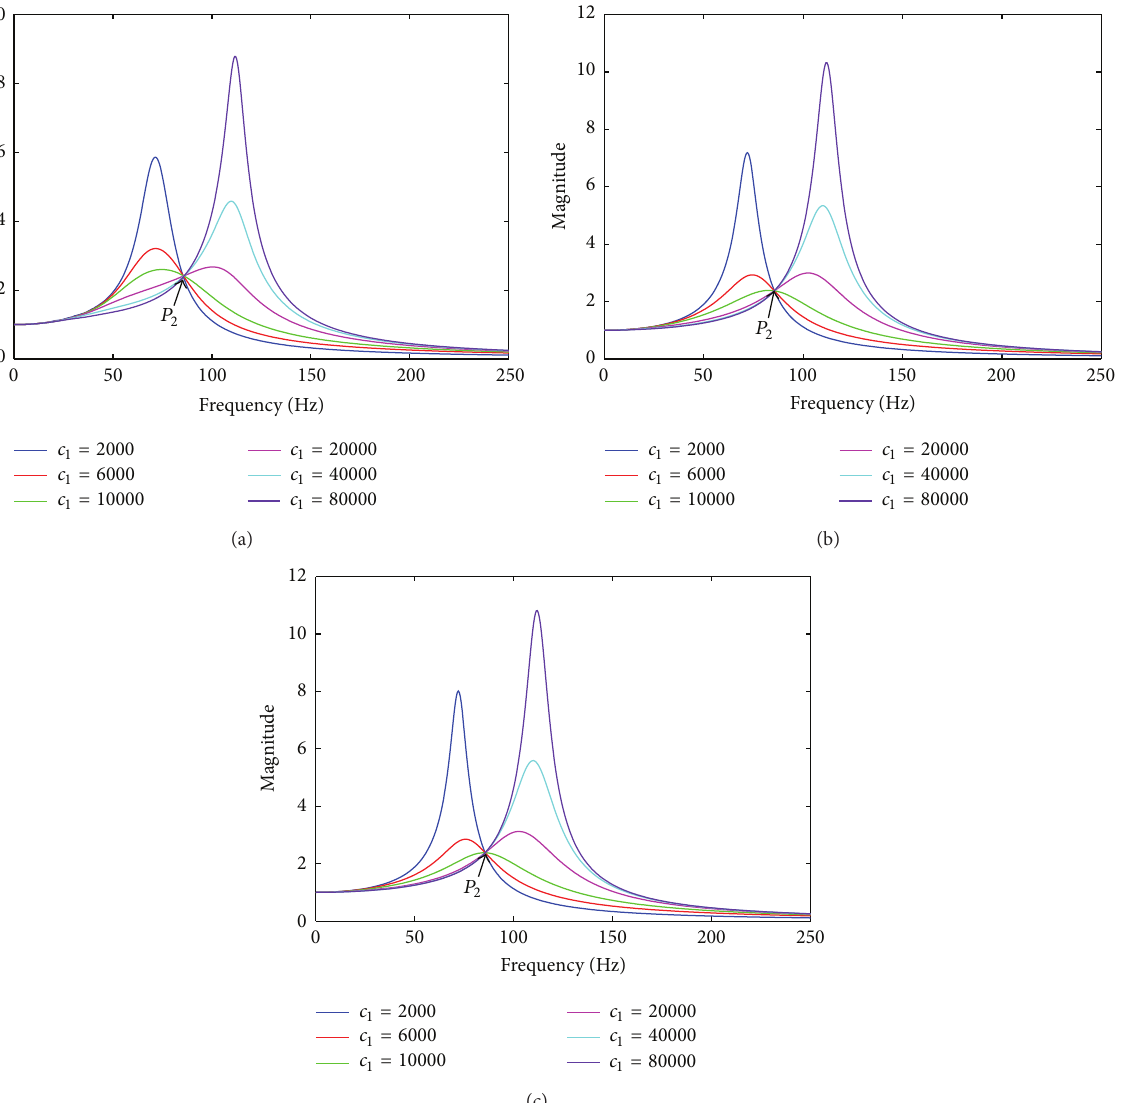
Figure 14: Absolute displacement transmissibility curves of GNM under 0.76 mm FDE cases. (a) 𝑛 1 = 1.5 ; (b) 𝑛 1 = 1 Maxwell model; (c) 𝑛 1 = 0.85